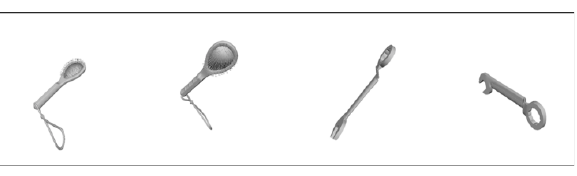
Figure 1:Examples of the stimuli; brush (left side) and wrench (right side) rotated in an angle of 90°. The initial object 0° is presented on the left and the rotated object on the